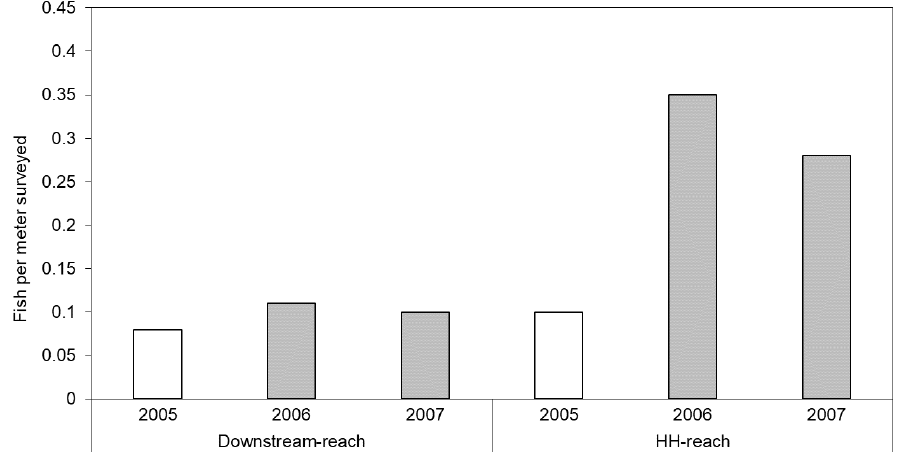
Figure 6. Number of fish (all species and size classes) per meter counted during snorkeling surveys. Data from 2005 (unshaded bars) were collected prior to initiation of restoration actions on the HH- reach.